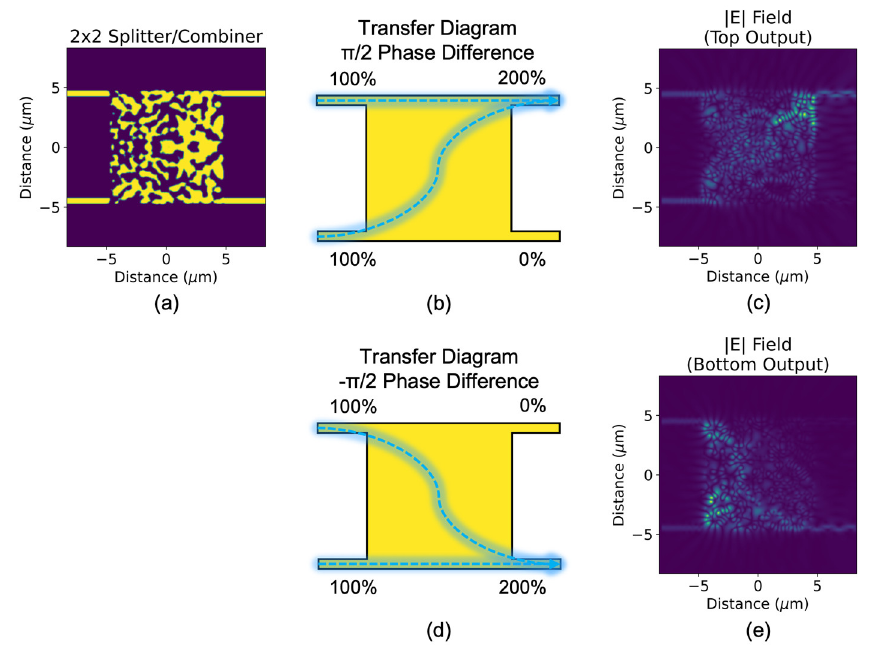
Figure 1. ( a ) Topologically optimized 2 × 2 3-dB splitter/combiner (in splitter mode) and its transfer diagrams for the following initial conditions: ( b ) input at the top waveguide, ( d ) input at the bottom waveguide. Top-view optical field profiles of ( b , d ) are shown in ( c , e ), respectively. The exact splitting ratios at 1550 nm are determined to be 0.466:0.490 and 0.456:0.472 for top-waveguide and bottom-waveguide inputs, respectively, which indicate low insertion loss (0.20 dB and 0.32 dB). For the two initial conditions that satisfy the combiner function, as shown in Figure 2, the phase of the two inputs determine which output port the signals combine at. For phase conditions A (inputs have a π/2 phase difference) and B (inputs have a -π/2 phase difference), the combining ratios are 1.840:0.042 and 0.003:1.882, respectively, which indicate low insertion loss (0.36 dB and 0.26 dB) and low crosstalk (−16.8 dB and −28.2 dB).